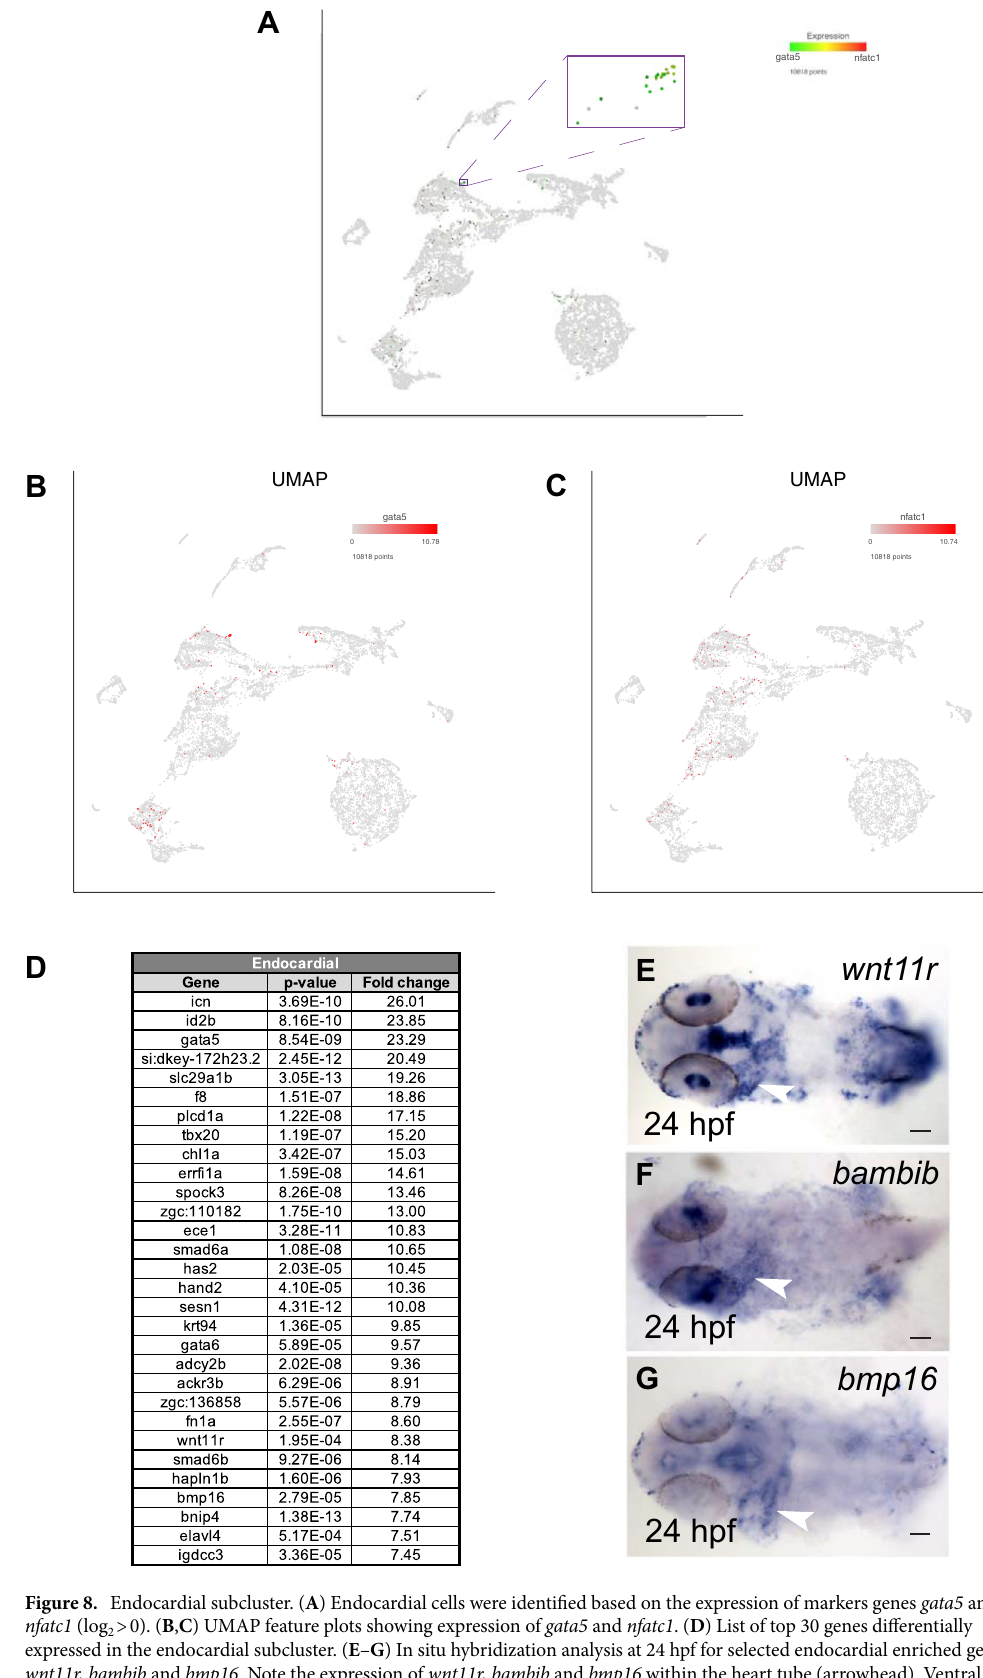
Figure 8. Endocardial subcluster. ( A ) Endocardial cells were identified based on the expression of markers genes gata5 and nfatc1 (log 2 > 0). ( B , C ) UMAP feature plots showing expression of gata5 and nfatc1 . ( D ) List of top 30 genes differentially expressed in the endocardial subcluster. ( E – G ) In situ hybridization analysis at 24 hpf for selected endocardial enriched genes wnt11r, bambib and bmp16 . Note the expression of wnt11r, bambib and bmp16 within the heart tube (arrowhead). Ventral view of deyolked and flat-mounted embryos, anterior is to the left. Scale bars: 100